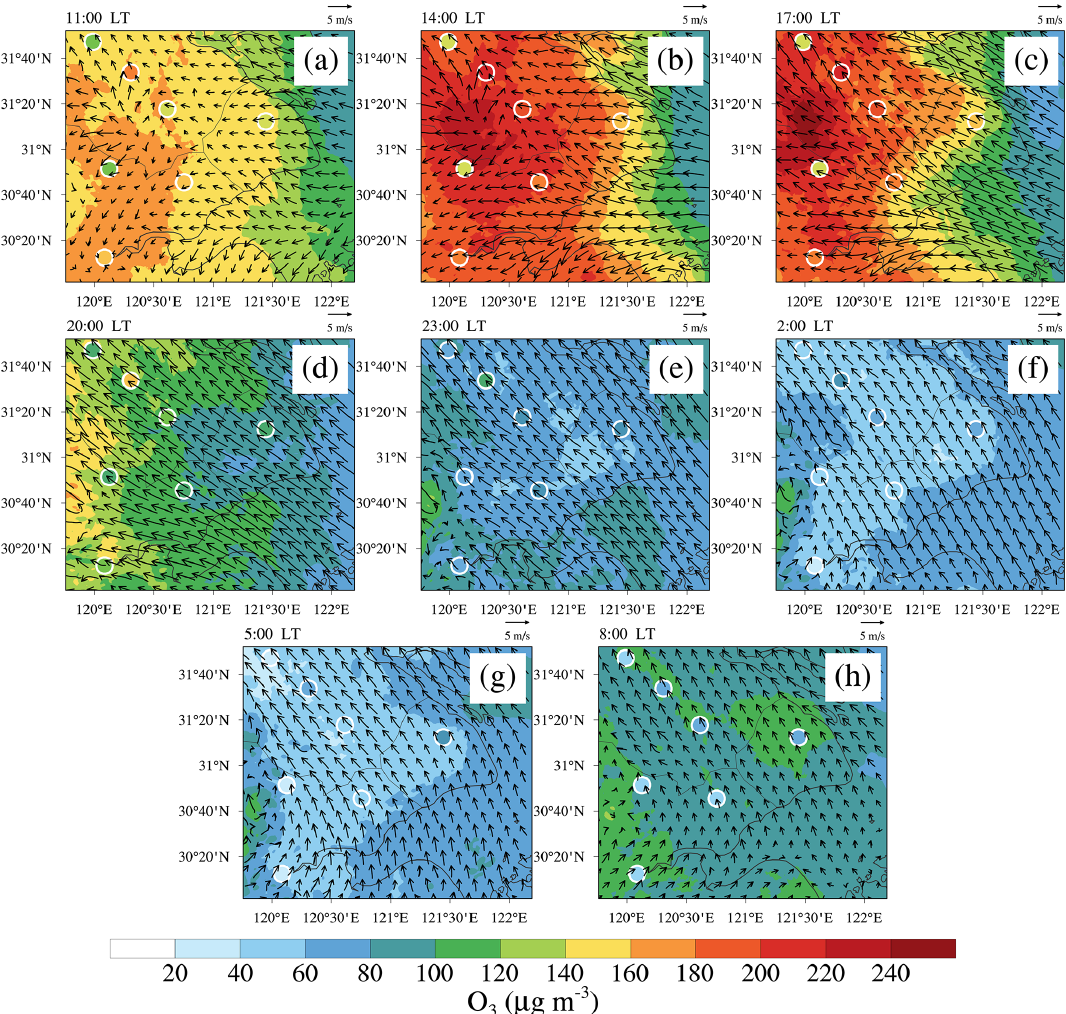
Figure 7. Horizontal distributions of O 3 and wind at the lowest model level in MODIS_noAH. Panels (a) , (b) , (c) and (d) show the results at 11:00, 14:00, 17:00 and 20:00LT, referring to the daytime. Panels (e) , (f) , (g) and (h) show the results at 23:00, 02:00, 05:00 and 08:00LT, referring to the night. The observations in different cities are overlaid using colored circles. To obtain universal features, all results are the average of the study period, and the same applies for the subsequent